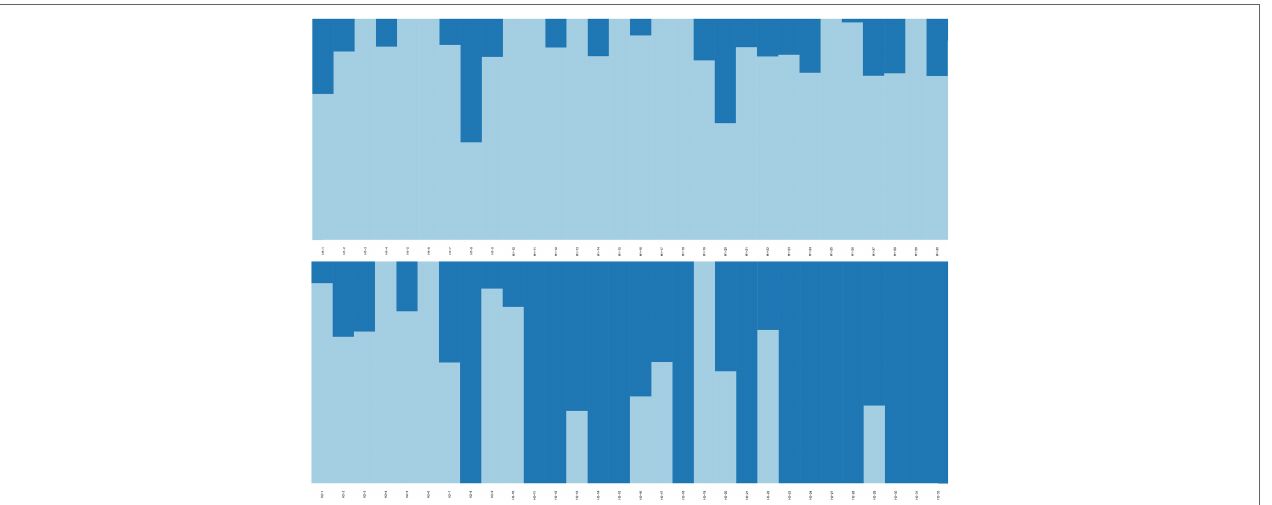
FIGURE 5 | Population genetic structure of G. haimaensis at H1 and H2 sites based on the entire set of 294,734 SNPs using STRUCTURE analyses (K=2). Each individual is represented by a single bar, with different colors showing membership fractions of each inferred cluster. H1 is shown above and H2 is shown below.